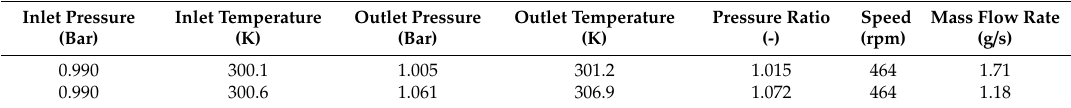
Table 2. Operating conditions for the Roots blower